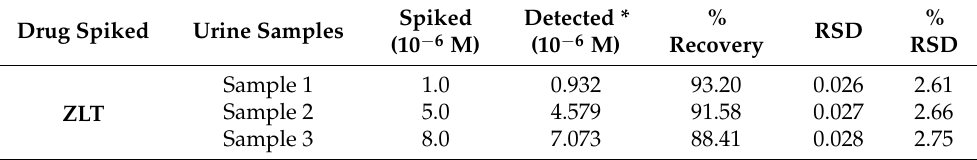
Table 2. Finding of spiked urine sample analysis.